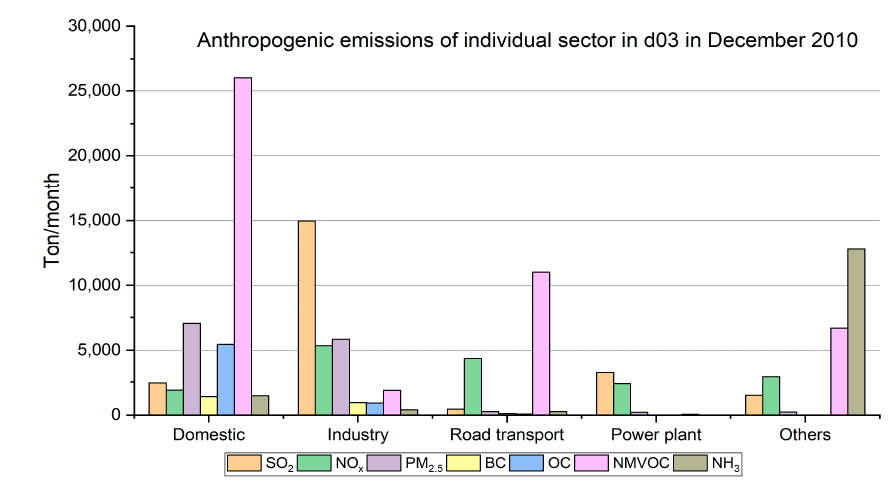
Figure 4. Anthropogenic emissions of individual sector in d03 in December 2010.